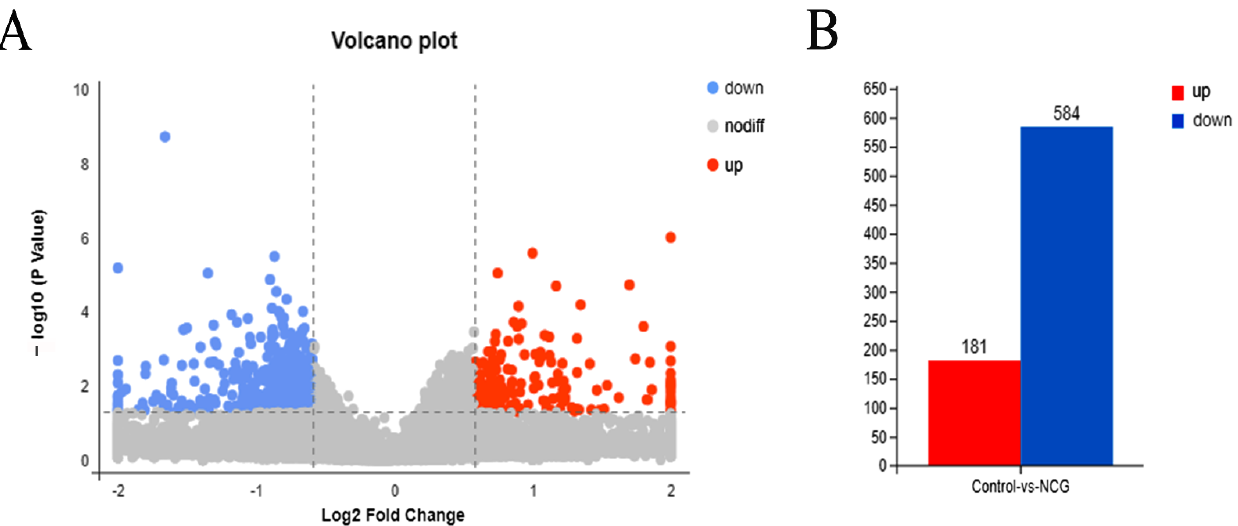
Figure 2. Volcano plot ( A ) and column ( B ) of the differentially expressed genes (DEGs) in ovarian tissues of Control and NCG group yaks. Blue, red, and grey dots denote downregulated ((FDR ≤ 0.05), upregulated (FDR ≤ 0.05), and non-differentially expressed (FDR > 0.05) genes in ovarian tissue from yaks in the NCG group ( n = 3) as compared to those in the Control group ( n = 3).